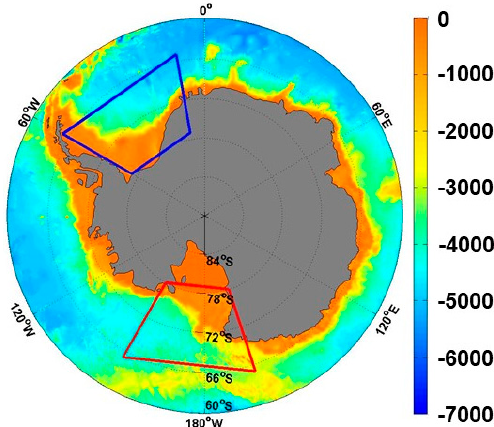
Figure 1. Study areas: Ross Sea (red box) and Weddell Sea (blue box). Bathymetry (in meters) is expressed in colour.